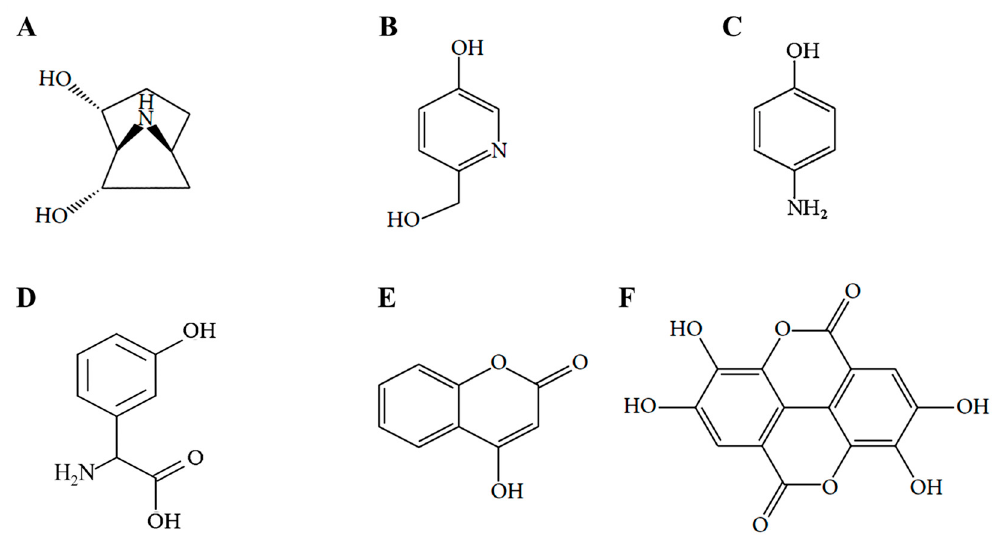
Figure 1. Structural formulas of the six bioactive compounds of 5- u RCK. ( A ) erycibelline, ( B ) 5- hydroxy-2-pyridinemethanol, ( C ) p-aminophenol, ( D ) m-hydroxyphenylglycine, ( E ) 4- hydroxycoumarin and ( F ) ellagic